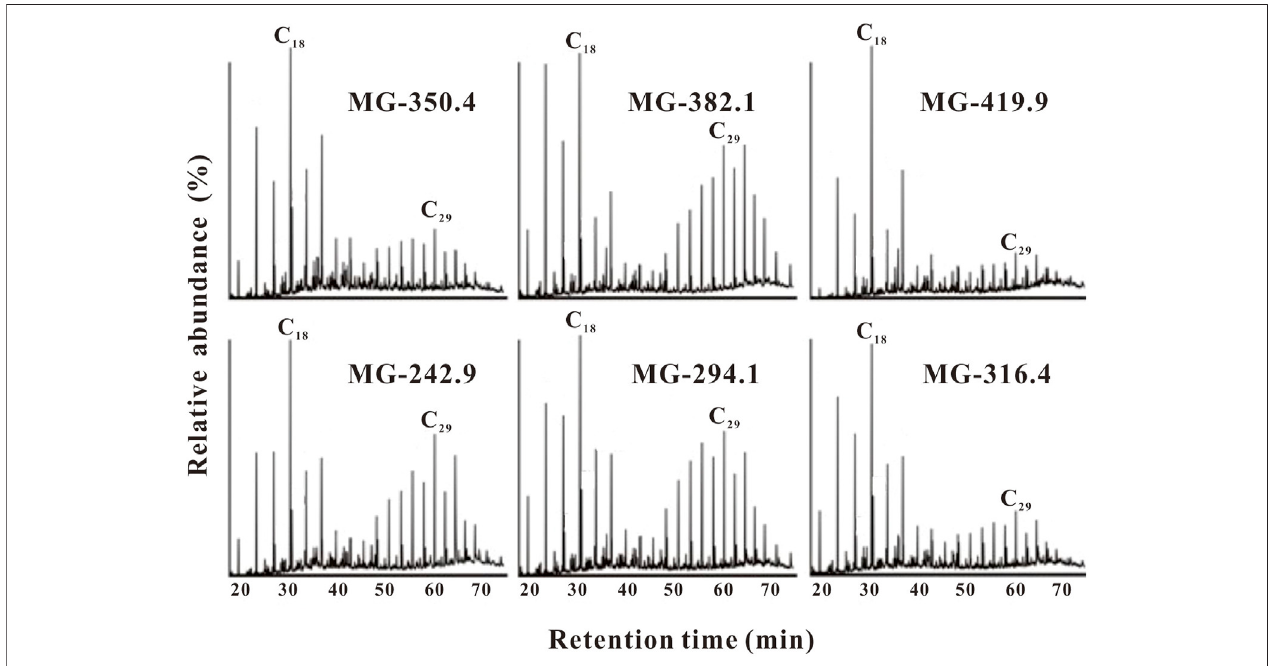
FIGURE 2 | Representative chromatographs of n -alkanes (m/z 85) in the Maogou sediments.